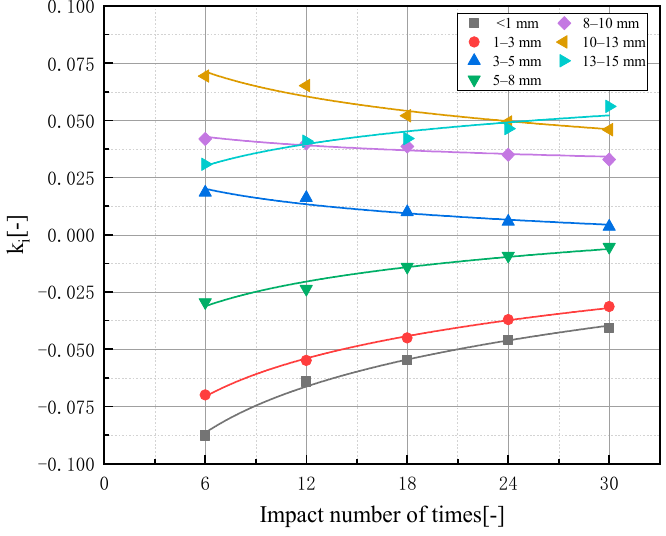
Figure 11. The degradation rate change of different classes of nodules after multiple impacts.